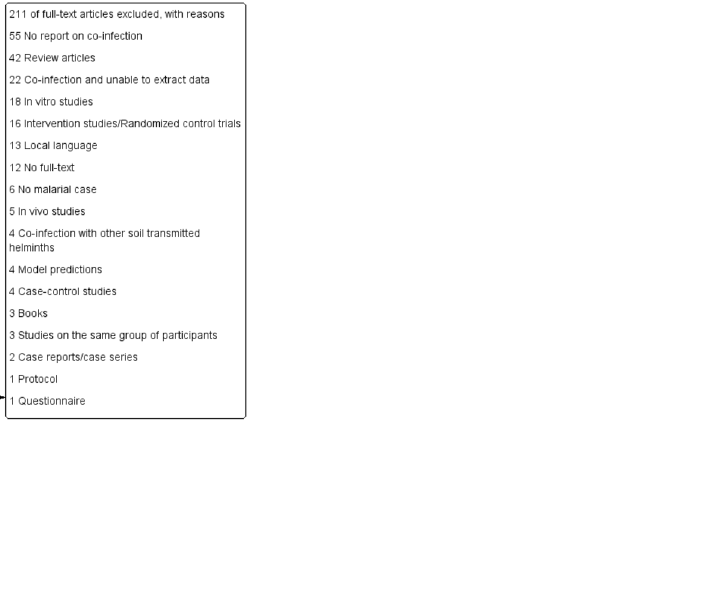
Figure 1. Study flow